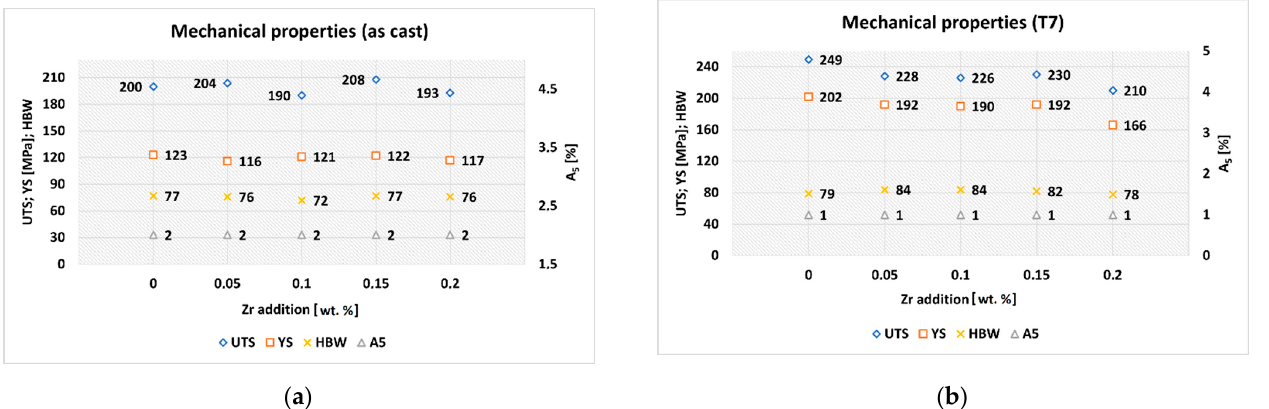
Figure 8. Mechanical properties of the experimental alloys AlSi5Cu2Mg: ( a ) as ‐ cast state; ( b ) after T7 heat treatment.